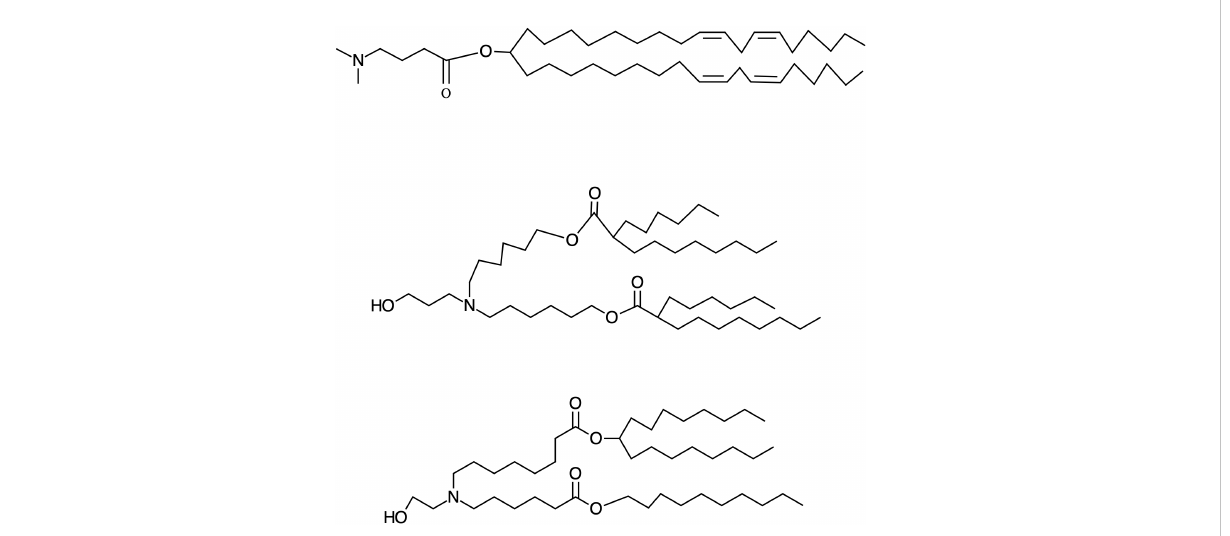
FIGURE 2 Structure of the approved Ionizable lipids. From up to down DLin-MC3-DMA, Alc-0315 and SM-102, the ionizable lipids present in Onpattro, Comirnaty (BioNTech/Pi fi zer) and Spikevax (Moderna), respectively, with the pKas: 6.44, 6.09, 6.75, respectively. The number of hydrophobic tails has geometrical consequences in the structure of the iLNPs contributing to the determination of size and robustness.